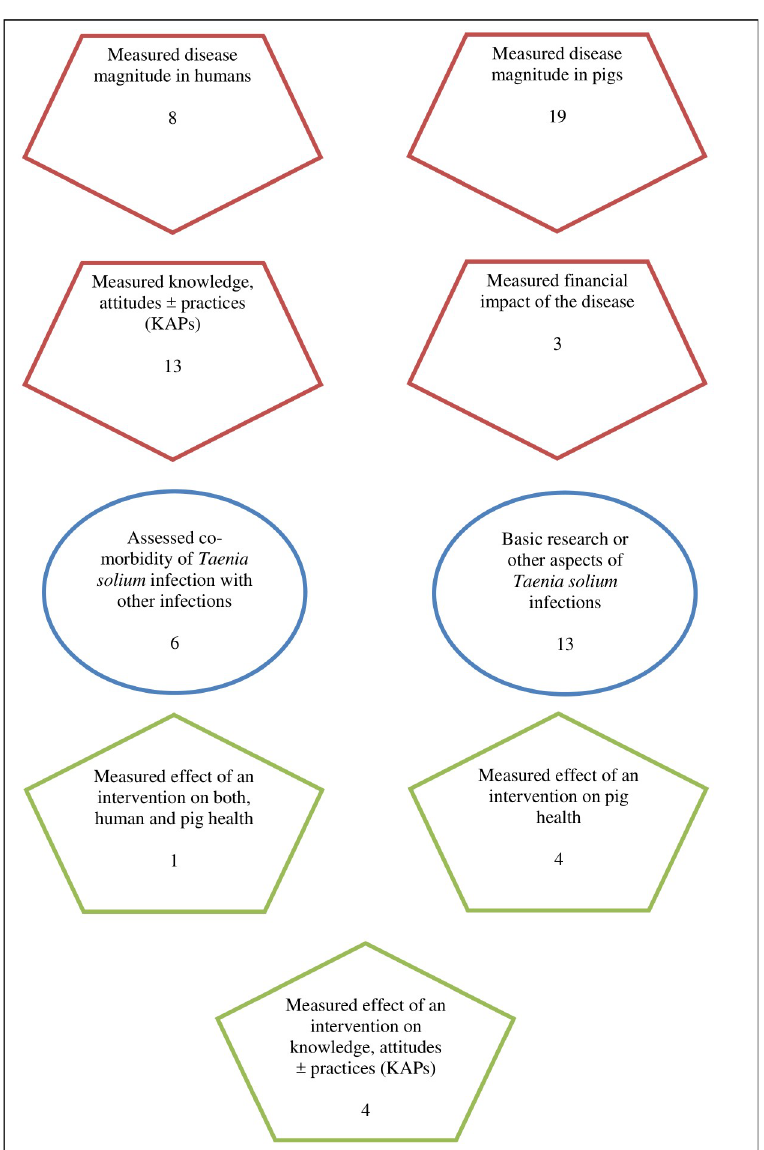
Fig 4. Number of previous Taenia solium taeniosis/cysticercosis studies by outcome measure in Tanzania, 1995– 2018. (Table 3). A longitudinal study composed of three cross-sectional surveys in Mbeya Region revealed temporal fluctuation of porcine cysticercosis seroprevalence [57].